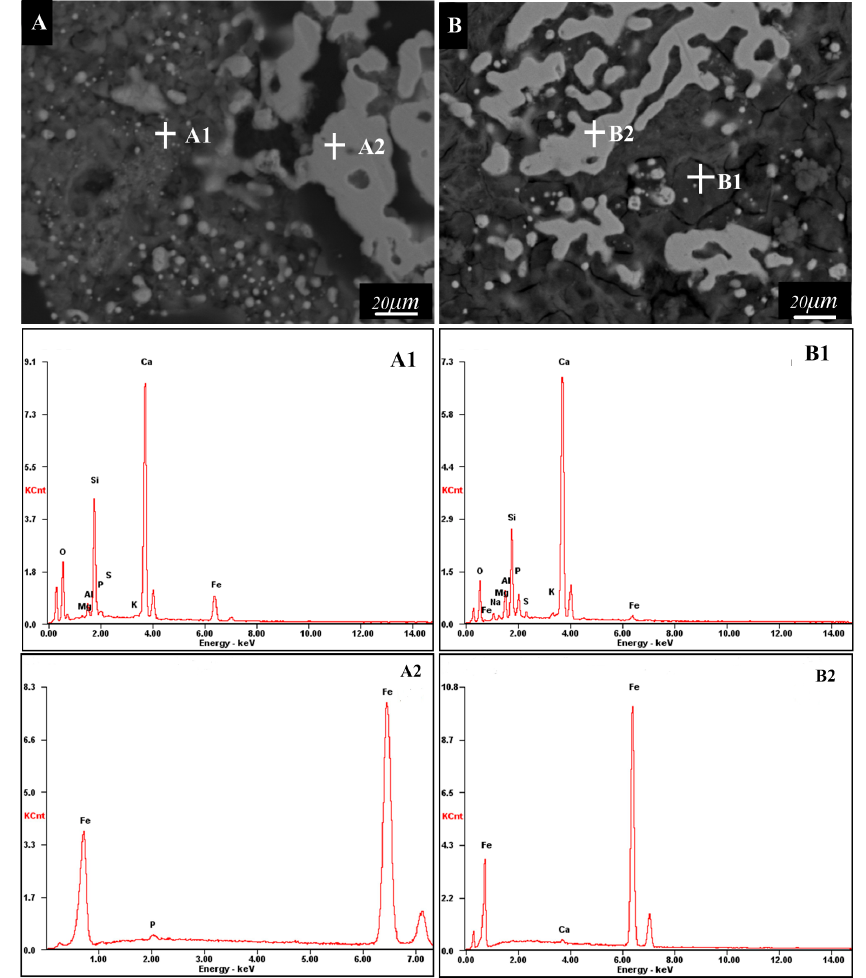
Figure 14. SEM-EDS image of reduced briquettes in the absence and presence of Na 2 SO 4 (reducing at 1350 °C for 10min with 2.4 basicity and C/Fe = 0.48). ( A ) No sodium sulfate; ( B ) 15% sodium sulfate. Table 8. Element content of different points in SEM.